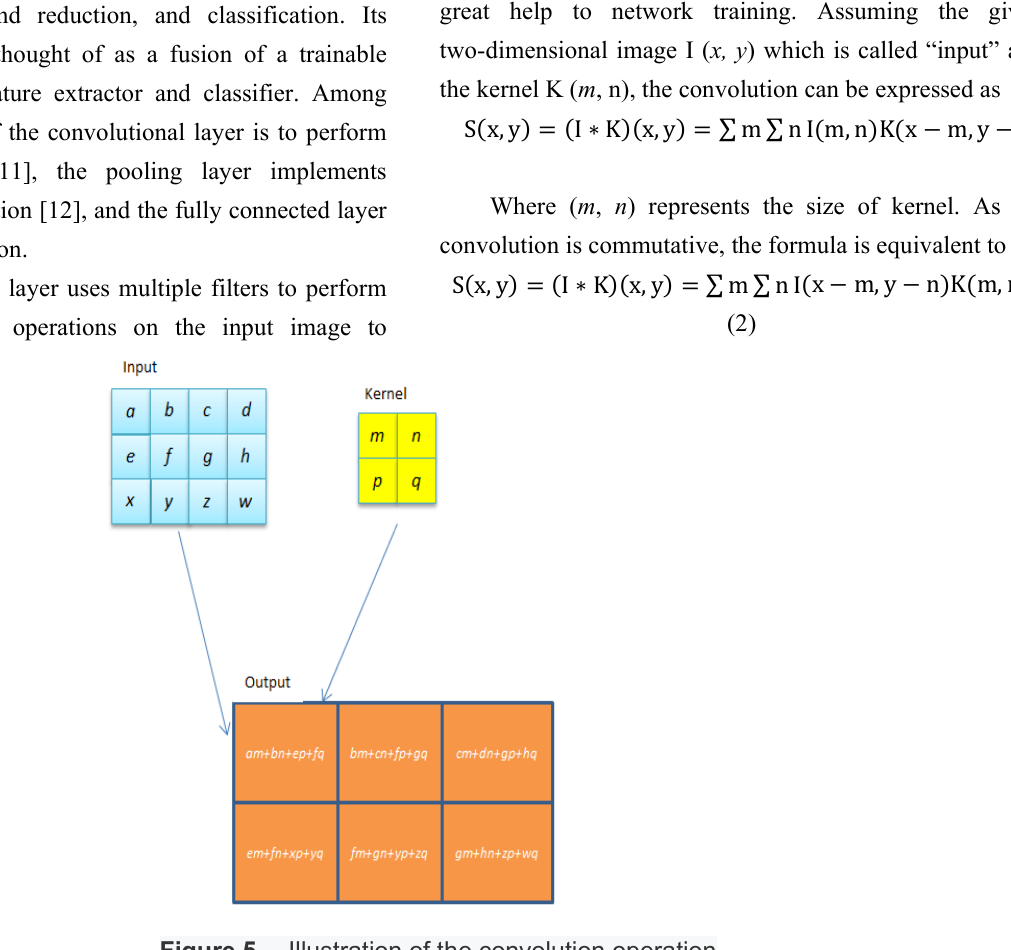
Figure 5. Illustration of the convolution